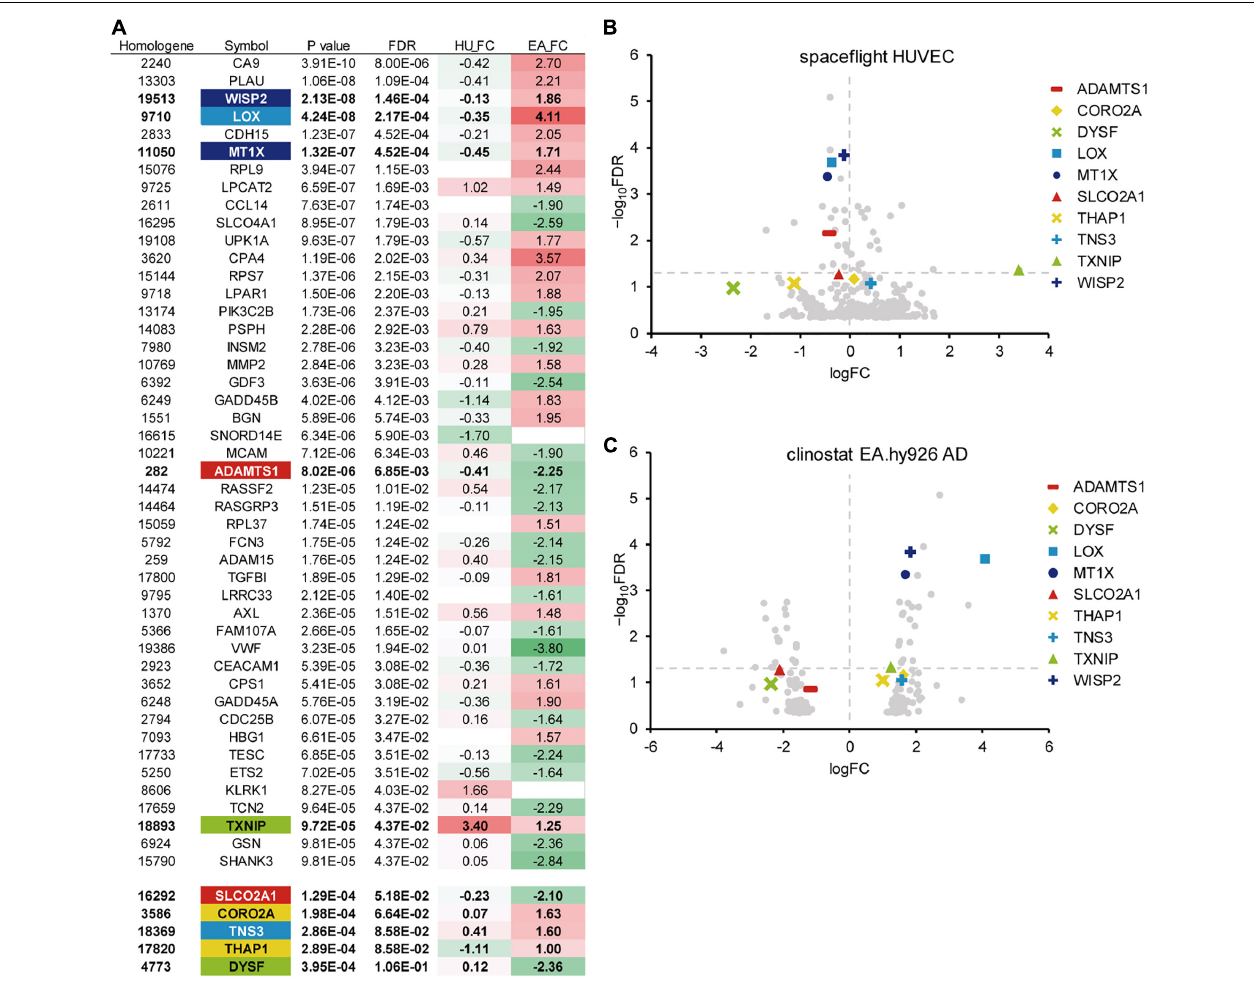
FIGURE 1 | A meta-analysis of gene expression in endothelial cells in response to microgravity conditions. (A) Top 46 genes with the smallest p -values (FDR < 0.05), which were identified from the DNA array analyses of human umbilical vein endothelial cells (HUVEC) and EA.hy926 cells under spaceflight and simulated microgravity conditions, respectively. Additional genes with relatively low p -values were listed below the top 46 genes. HU_FC: Log fold change value in HUVEC. EA_FC: Log fold change value in EA.hy926 cell. (B) The Volcano plot of the space flight HUVECs. (C) The Volcano plot of the clinorotated EA.hy926 cells. Horizontal dotted line: a line at which FDR is equal to 0.05. Vertical dotted line: a line at which logFC is equal to